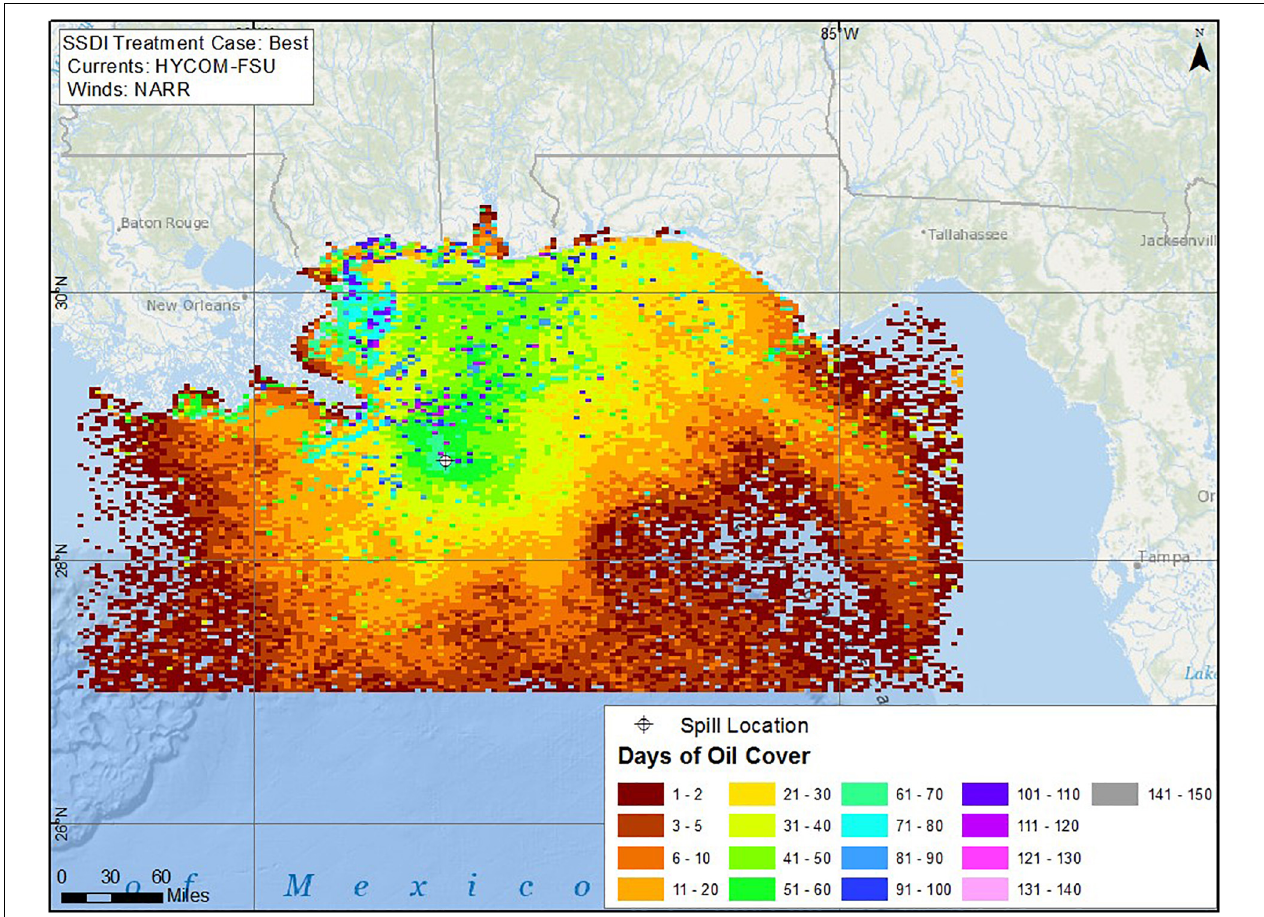
FIGURE 3 | Cumulative days of oil presence on the water surface, based on the base case model simulation using HYCOM-FSU currents and NARR